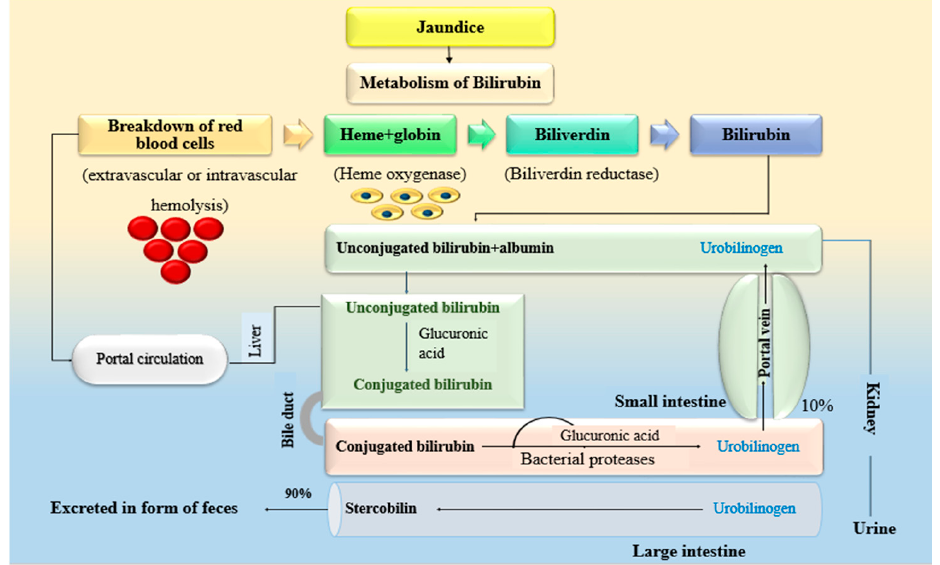
Figure 1. Bilirubin metabolism or pathophysiology of jaundice [15].